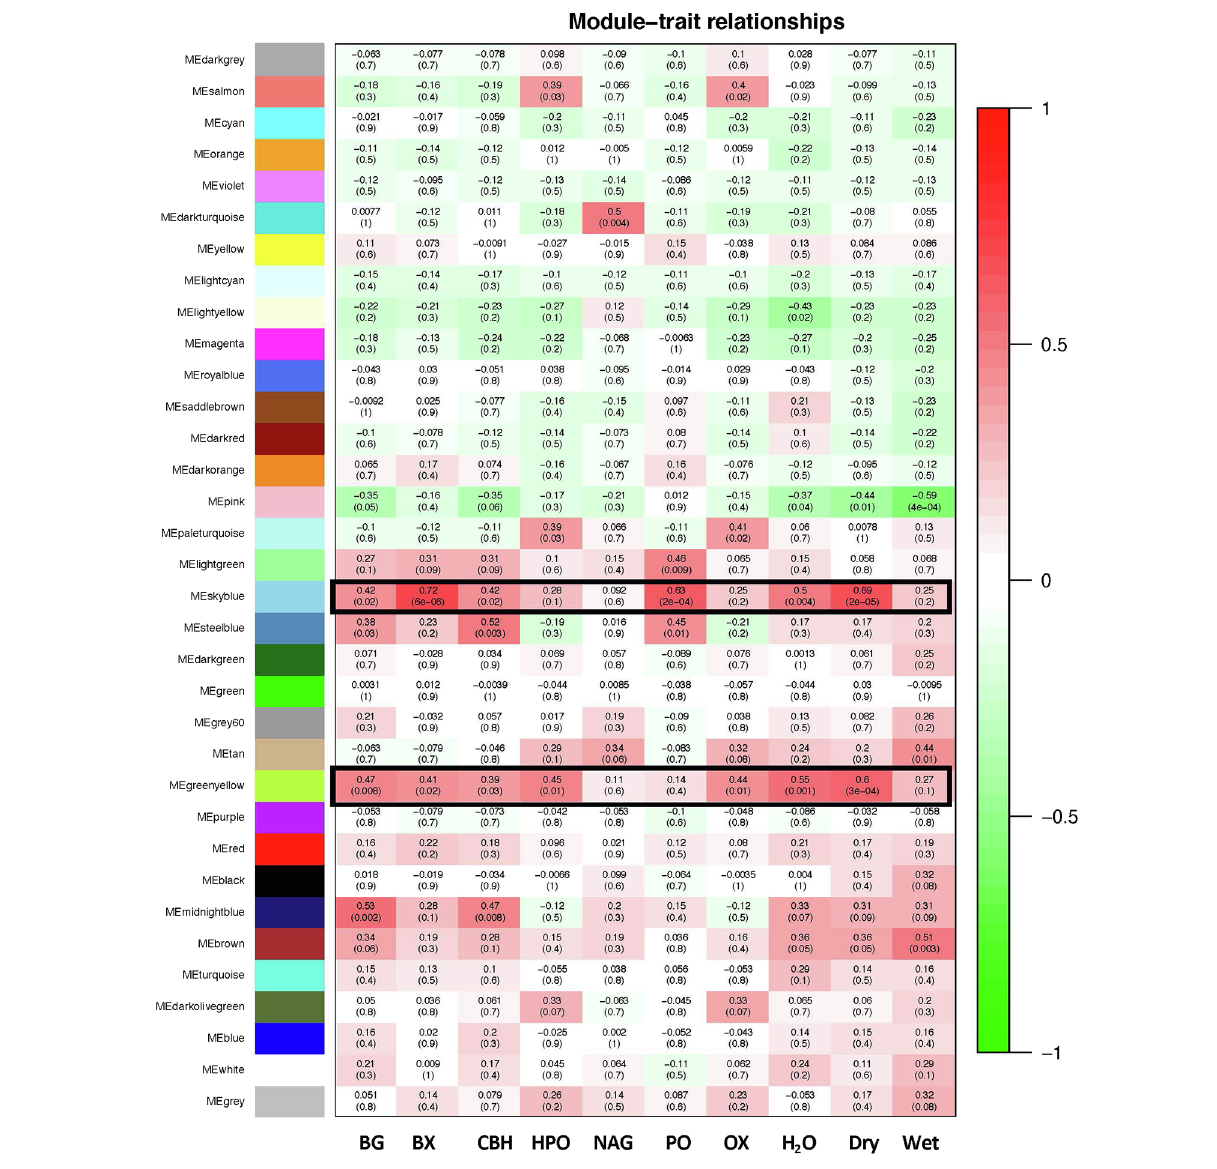
FIGURE 5 | Co-weighted network analyses – module-trait associations between KEGG annotated transcript abundances and enzyme concentrations and physical soil parameters. Each row corresponds to a module eigen gene and each column represents a trait. The top number indicates the correlation (|cor|) between the eigen gene value and the individual trait and the bottom number indicates the p -value. The colors from green to red indicate positive or negative correlation, respectively. Enzyme codes – BG, β -glucosidase; BX, β -xylosidase; CBH, cellobiohydrolase; HPO, peroxidase; NAG, β -N-acetyl-glucosaminidase; PO, phenol oxidase; dry, dry weight of samples; and wet, wet weight of samples. Trait data are taken from Pold et al.